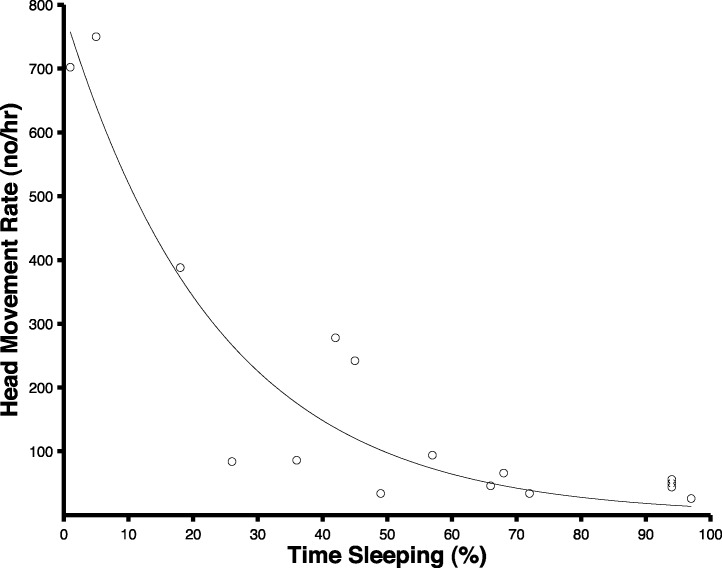
Peahens that exhibited lower head movement rates spent more time sleeping.Because each peahen was sampled during two periods (see “Methods”), there are two circles per bird.